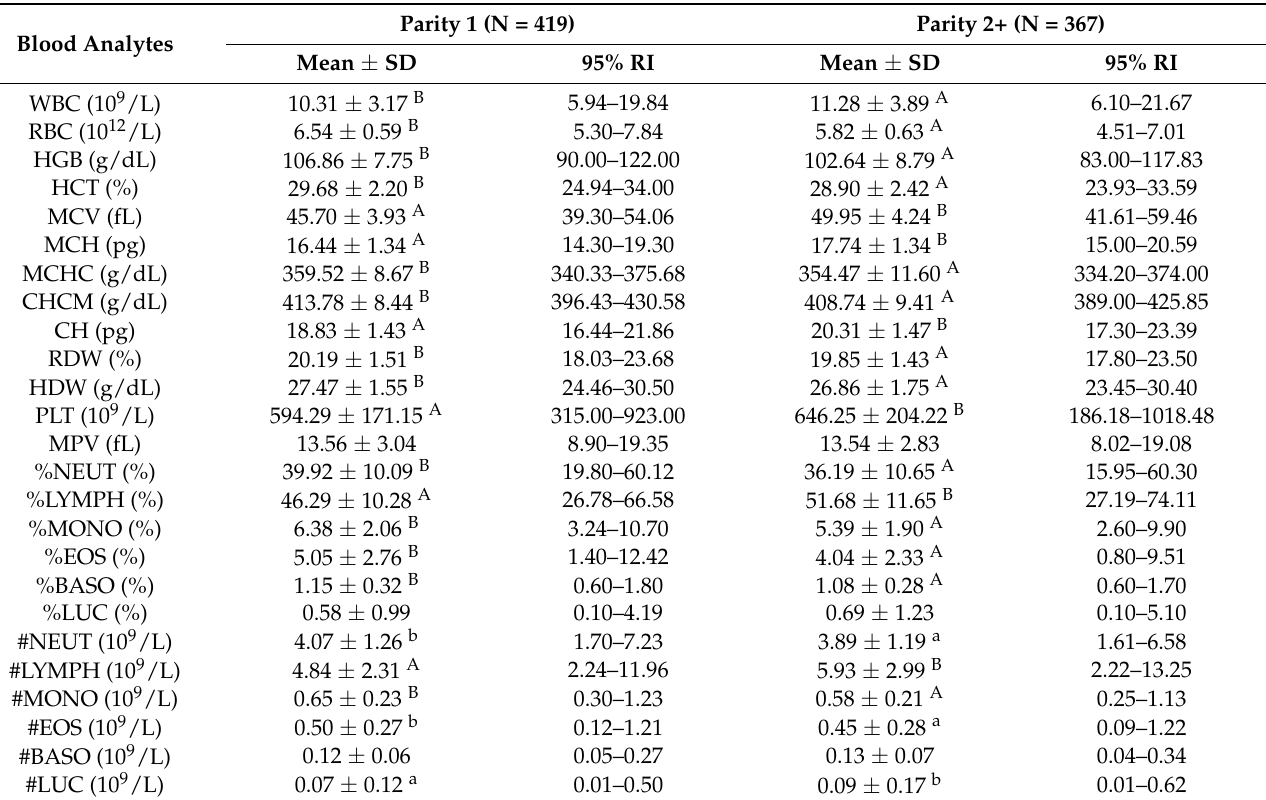
Table 3. Hematology values and RIs for Holstein cows at different